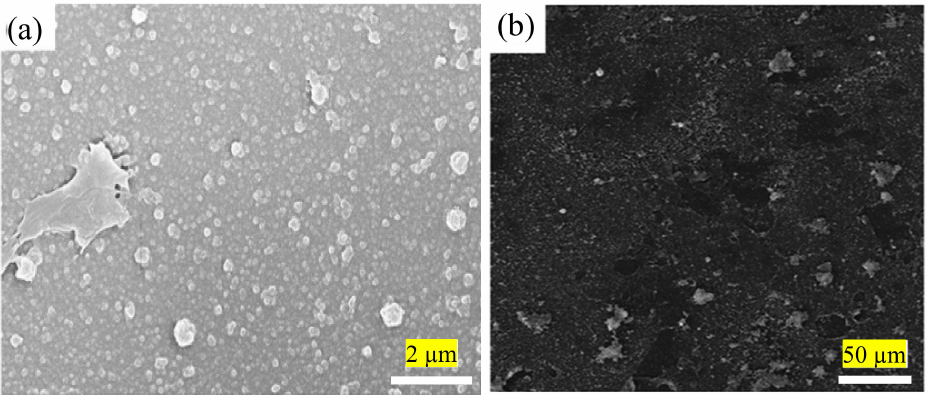
Figure 3. ( a ) SEM images showing agglomeration of modified-graphene oxide (GO) [48] and ( b ) multi-walled carbon nanotubes (MWCNTs) [72] in the PA layer of